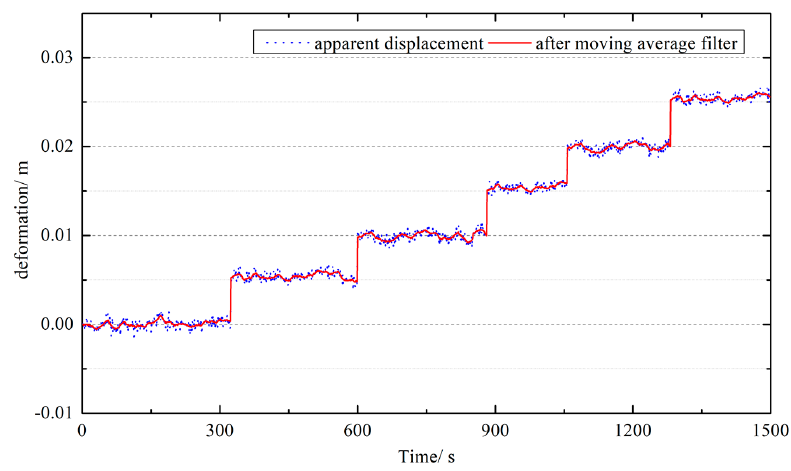
Figure 15. Automated horizontal shift detection based on deformation. The antenna was shifted repeatedly at distances ranging from 10 cm to 1 cm. The blue dot line is the apparent displacement derived from short baseline solution. The red line is the deformation after applying the moving average filter method.